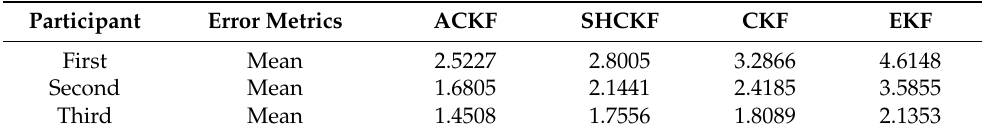
Table 4. Comparisons of mean localization errors